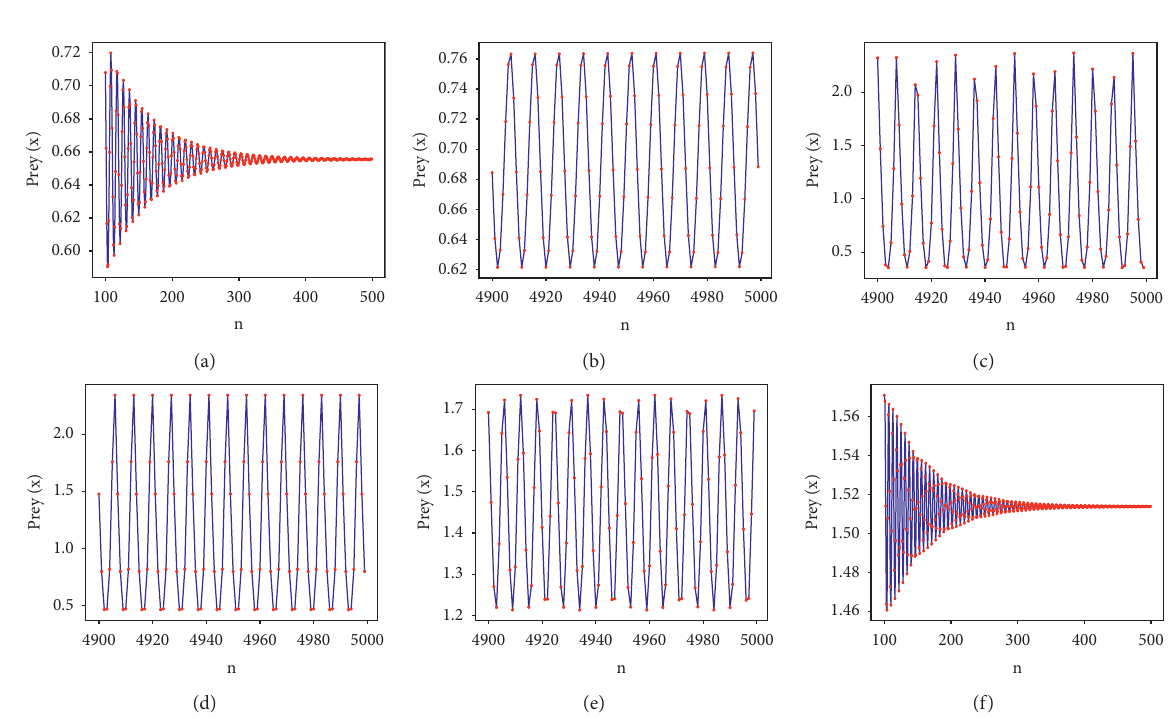
Figure 4: The time series plots for system (5) with r m � 0 . 18, ((b), (c)) invariant circles for m � 0 . 2 , 0 . 5, (d) period-8 for m � 0 . 58, (e) invariant circle for m � 0 . 88, and (e) asymptotically stable for m � 0 .